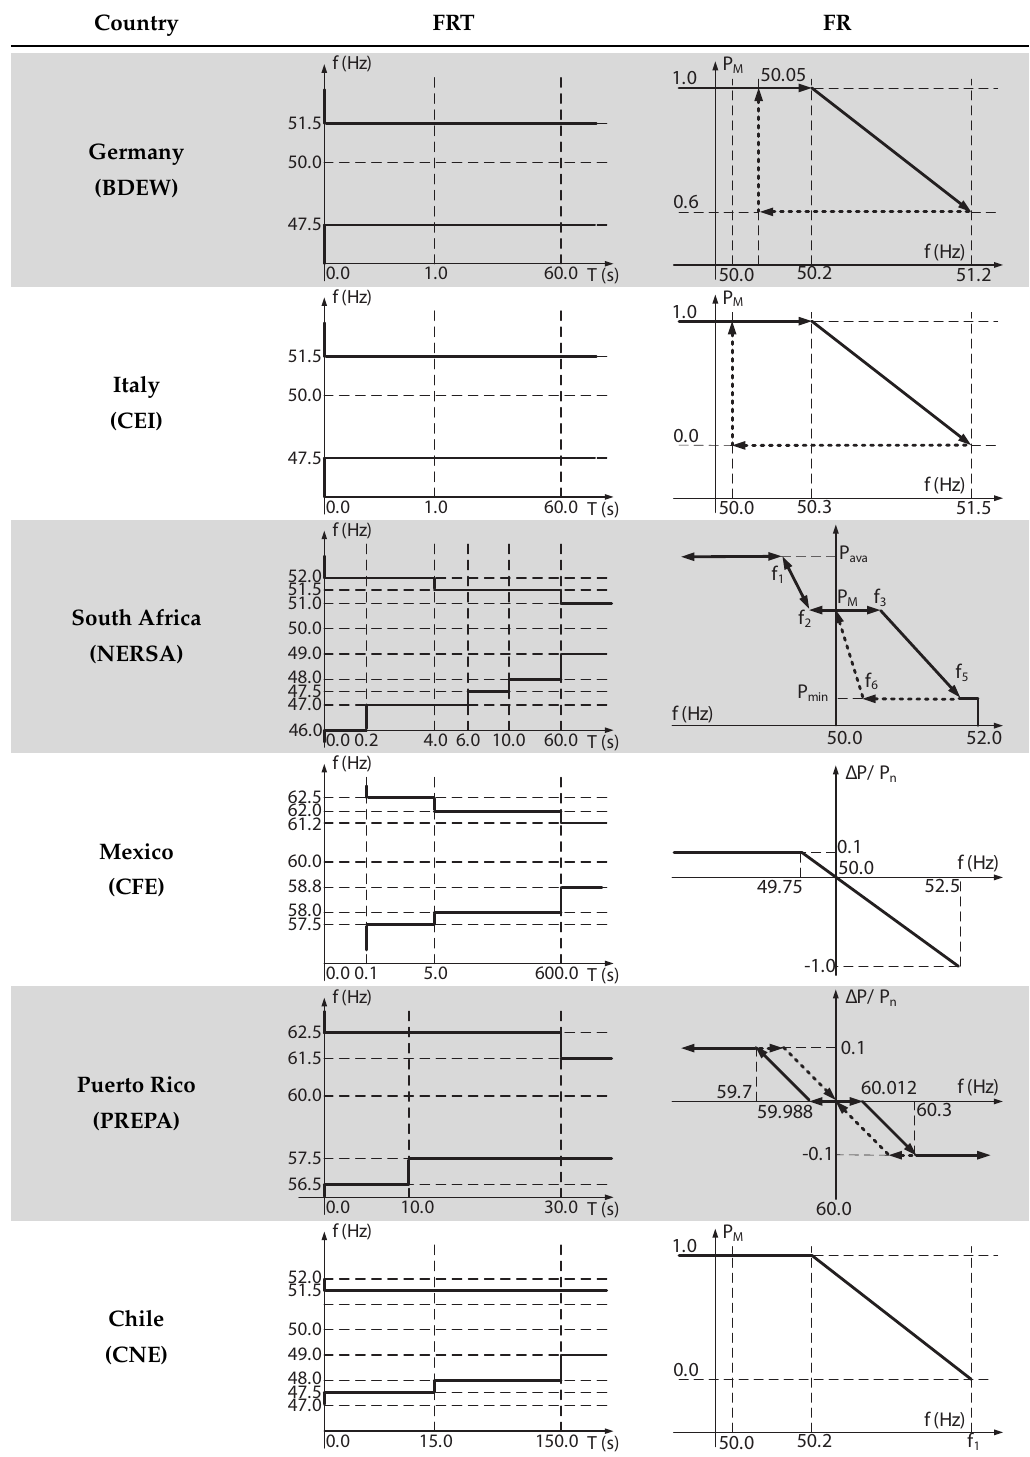
Table 1. FR utility-scale photovoltaic plants (USPVPs) minimum technical requirements (MTRs) review. FRT: frequency ride through; BDEW: German association of energy and water industries; CEI: Electrotechnical Italian Committee; NERSA: National energy regulator of South Africa;